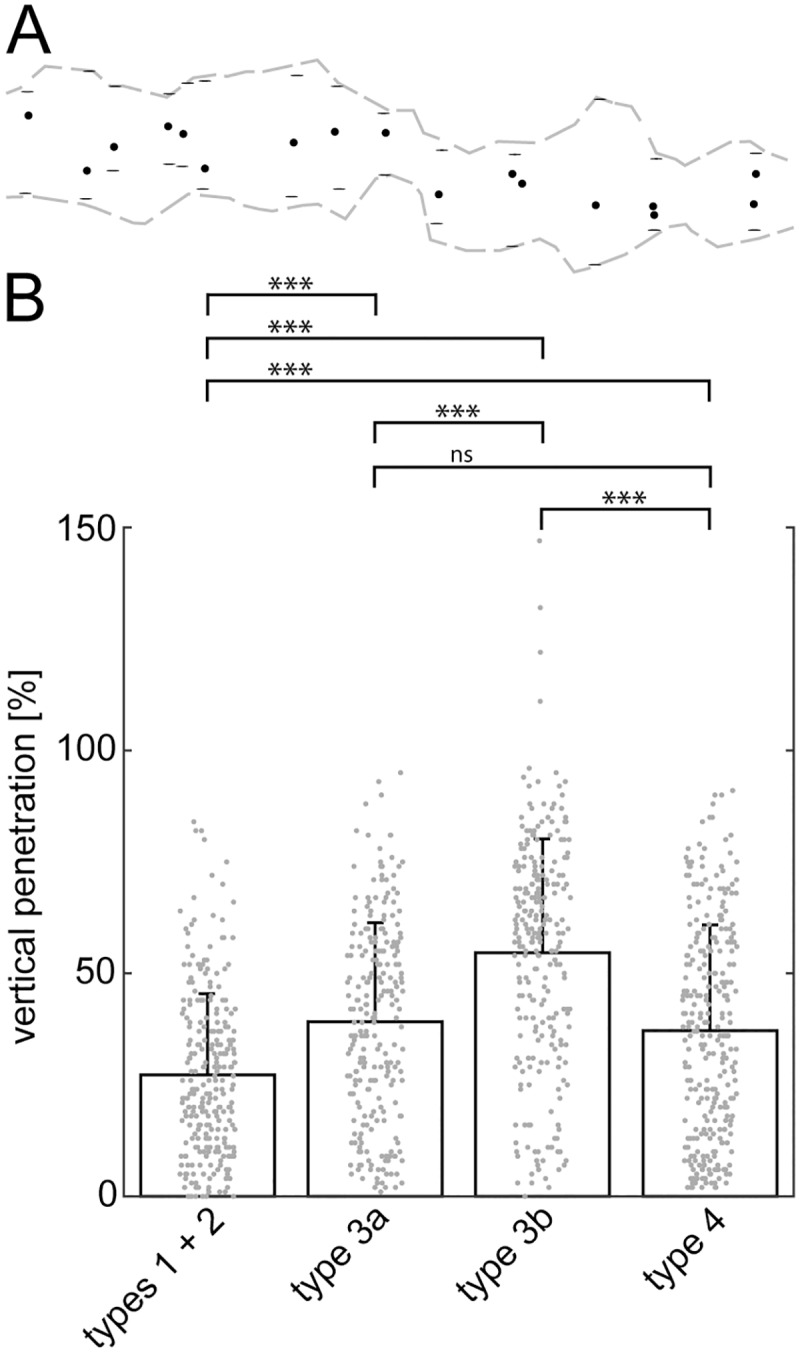
Vertical penetration depth of OFF bipolar cell dendrites through the OPL of Nrl-/- retinas.A: Schematic showing the outline of the CtBP2-labeled area in the z-projection of Fig 1O (gray dashed lines). Horizontal bars show local borders of the CtBP2-labeled area within the stack where measurements were taken. Vertical penetration depth was measured in single optical sections of the image stacks as the distance between the inner border of the ribbon label (lower horizontal bars) and the location of each dendritic tip (black dot) relative to the whole width of the ribbon label (distance between lower and upper horizontal bar). B: Quantification of the extent of dendritic extension through the OPL in Nrl-/- mice. Individual measurements are shown as gray dots. The four measurements of values higher than 100% (outer margin of the ribbon label) in case of type 3b OFF bipolar cells occur due to extension of dendrites into the ONL. The bar plots show the mean penetration depth, error bars indicate the standard deviation from the mean. *** indicates significant differences (p<0.001) between corresponding types as determined by Dunn’s Multiple Comparison post-hoc tests (ns, not significant, p>0.05).